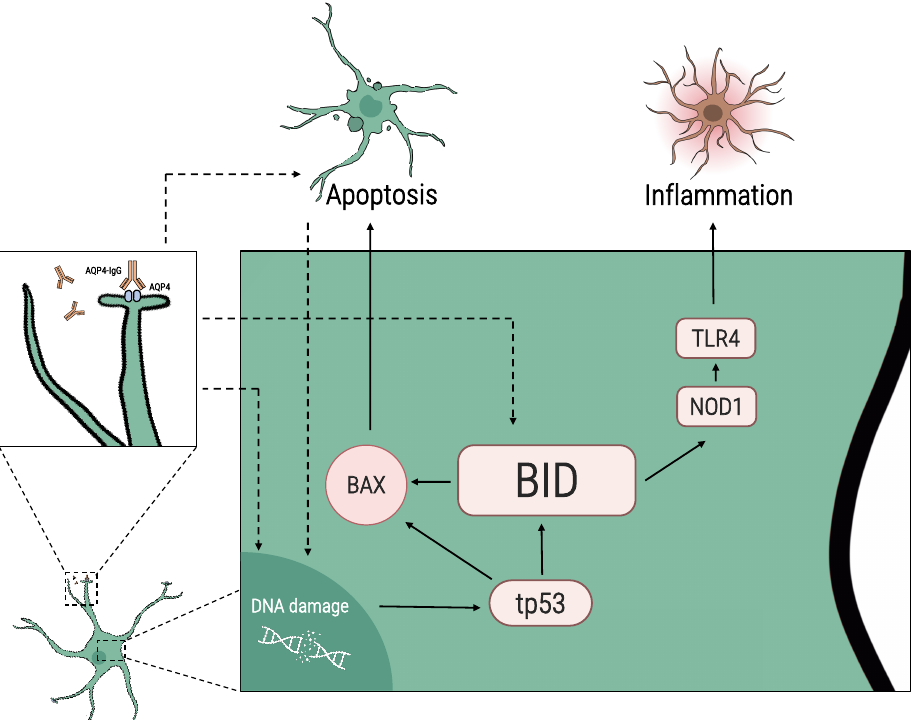
Figure 8. Proposed scheme for BID-mediated apoptosis in astrocytes in NMO. Following culture of astrocytes with sera of NMO patients, we found an increase in the expression of BID , tp53 , BAX , NOD- 1 , and TLR4 . Increased BID levels may be linked to NMO pathogenesis through several pathways: The increase in BID can mediate the inflammation process in NMO by increasing NOD-1 and TLR4 . The interaction of AQP4-IgG and AQP4 receptors on astrocytes leads to complement activation, necrosis/apoptosis, and DNA damage, which in turn may activate cell-cycle regulator tp53 , leading to BID-mediated apoptosis. Other inflammatory factors in the sera of NMO patients can directly activate the BID pathway or indirectly by increasing DNA